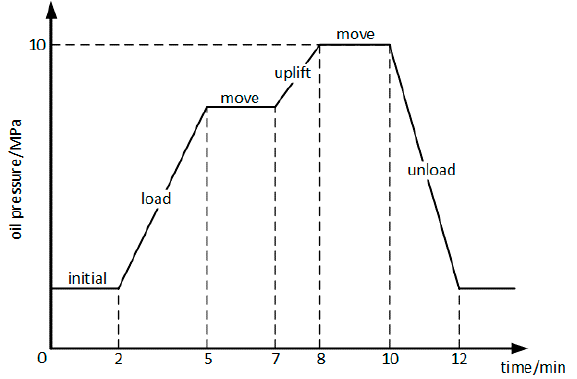
Figure 5. Mission profile of a transfer task.